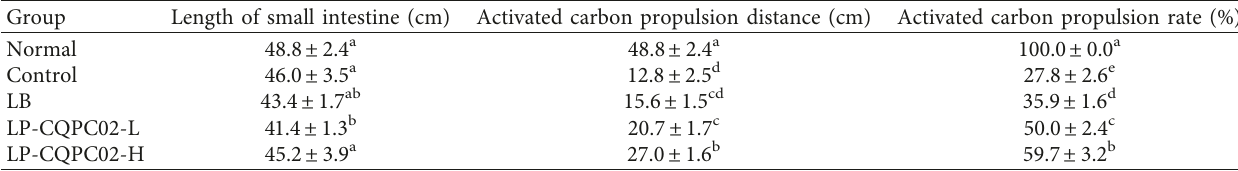
Table 2: Activated carbon propulsion rate of mice with activated carbon-induced constipation.